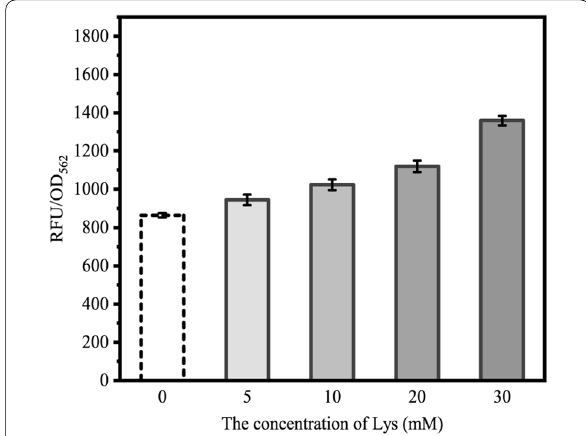
Fig. 2 The response of the native LysG-P lysE biosensor in pMK to Lys. The relative eGFP fluorescence intensity of evolutionary strain SZ06/ pMK was detected under different concentrations of